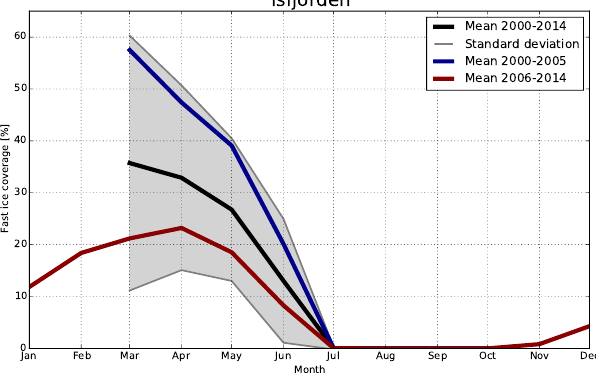
Figure 7. Onset of sea ice cover in Isfjorden and Hornsund. The years refer to the sea ice season, which starts during the previous year, meaning that January marks the beginning of the respective year. The triangles and dots mark the days with first appearance of drift and fast ice, i.e. the start of the sea ice season. Too few satel- lite images were available for Isfjorden in 2007 to give a reliable